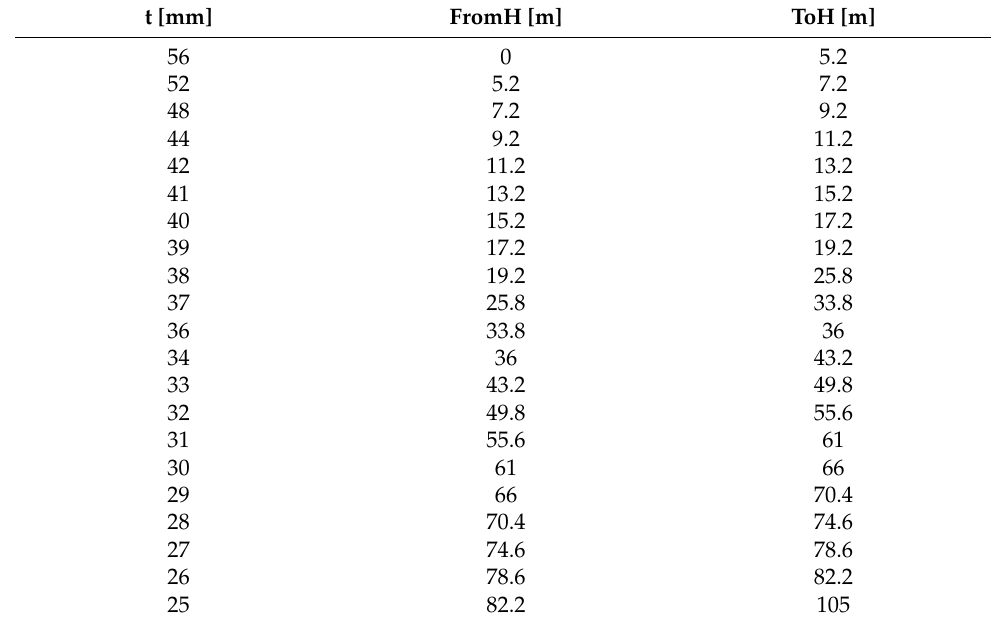
Table 5. Optimum tower segment thickness of 10 MW+ offshore wind turbine